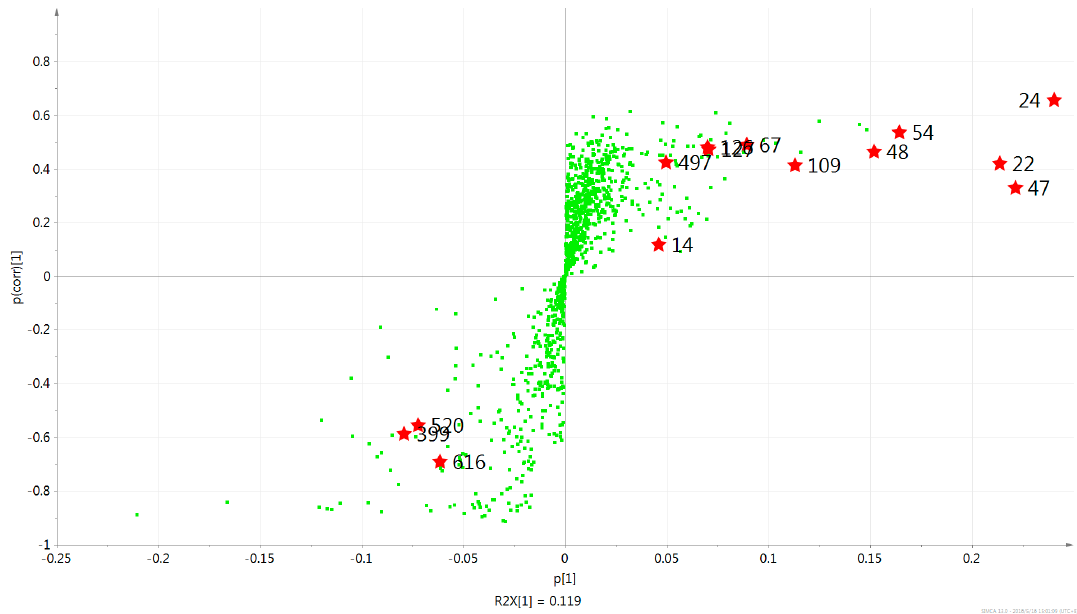
Figure 7. S-plot generated by orthogonal partial least squared discriminant analysis (OPLS-DA) for the metabolites in the wild and cultivated agarwood.